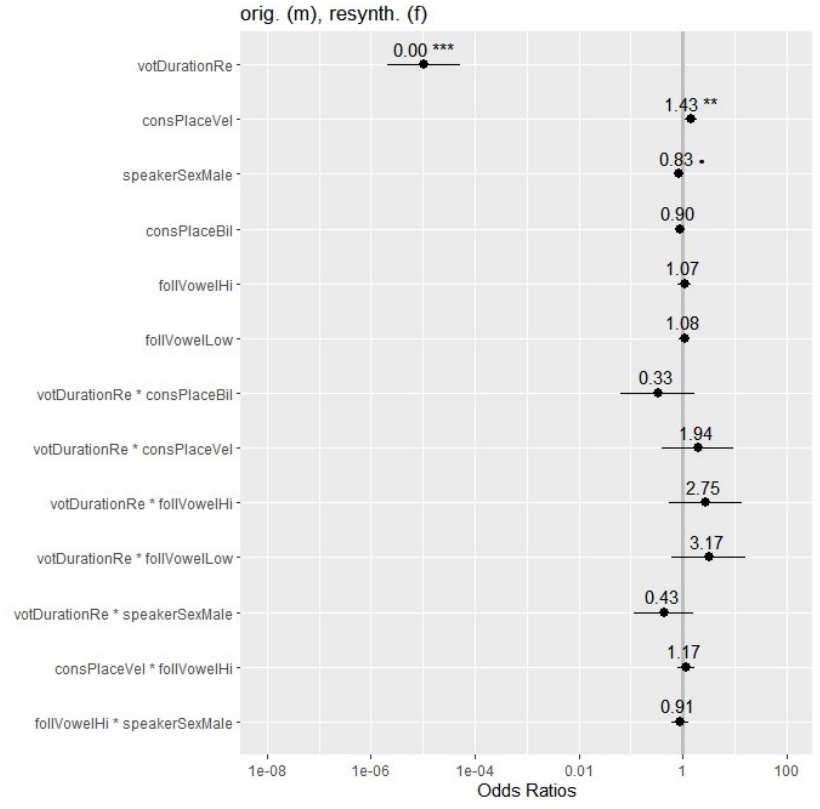
Figure 5. Odds ratios (ORs) of ‘voiced’ responses across the fixed effects and interactions in the glmer model for the original male and resynthesized female tokens in the − 20 ms to +20 ms VOT range. Significance is shown with asterisks (‘***’: <0.001; ‘**’: <0.01; ‘.’: <0.1). Confidence intervals (CIs: 95%) are marked with